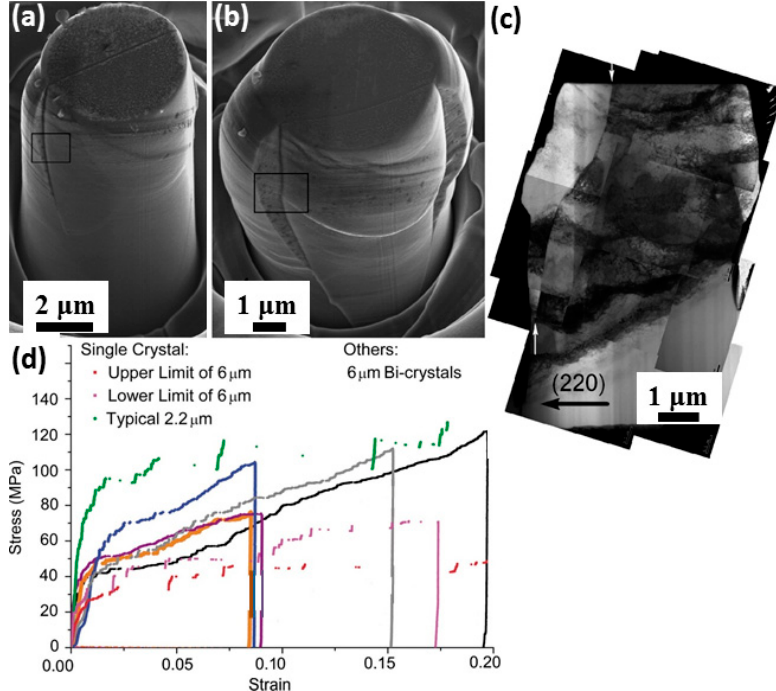
Figure 4. SEM image of ( a ) a mildly-deformed (up to ~7% strain) bi-crystal pillar corresponding to the orange curve in ( d ); ( b ) a severely-deformed (up to ~20% strain) bi-crystal pillar corresponding to the black curve in ( d ); all pillars have diameters of ~6 μ m, except the green curve, which corresponds to a typical 2.2 μ m [641]-oriented single-crystal column. Nominal stress-nominal strain curves for [641]-oriented single crystal and bi-crystal Al pillars. ( c ) Postmortem TEM image showing the deformed bi-crystal pillar in ( b ). The GB was indicated by two arrows in the left [34] ( Reprinted from Philosophical Magazine, Copyright 2009, with permission from Taylor & Francis